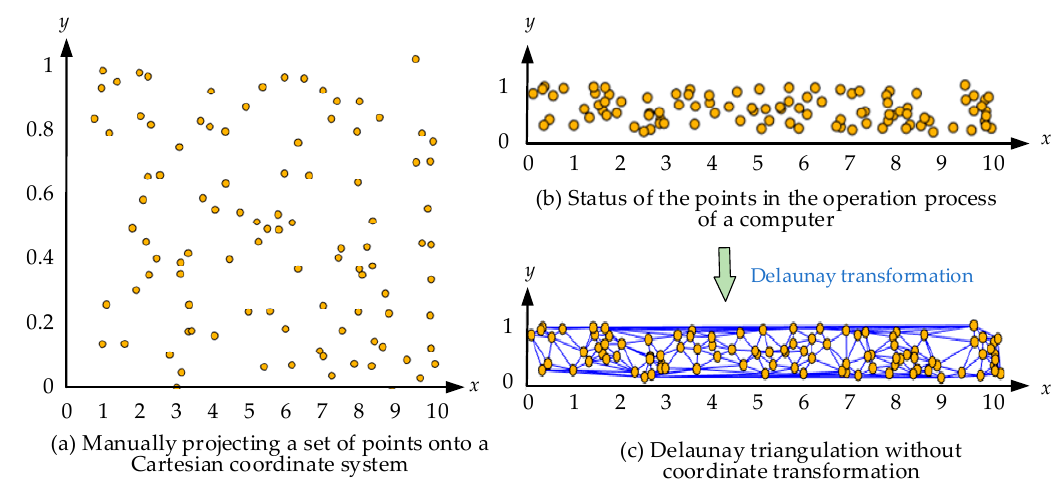
Figure 4. Distributions of sample points when the length of the x -axis and the length of the y -axis are not of the same order of magnitude. ( a ) Manually projecting a set of points onto a Cartesian coordinate system; ( b ) Status of the points in the operation process of a computer; ( c ) Delaunay triangulation without coordinate transformation.